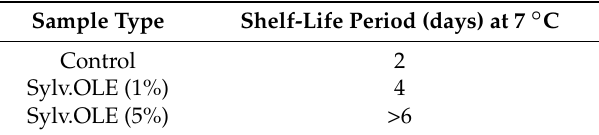
Table 4. Shelf-life (days)